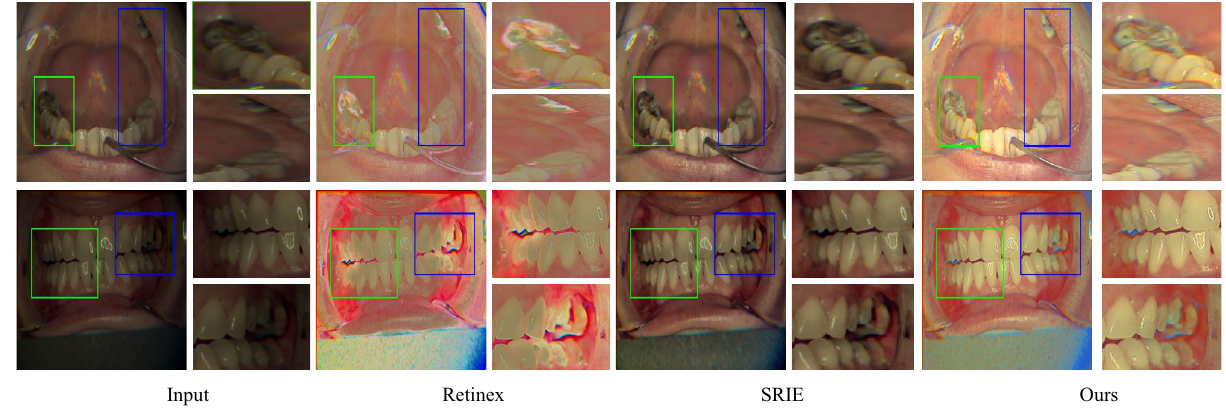
Figure 10. Comparison of the proposed method (ours) with decomposition-based approaches.